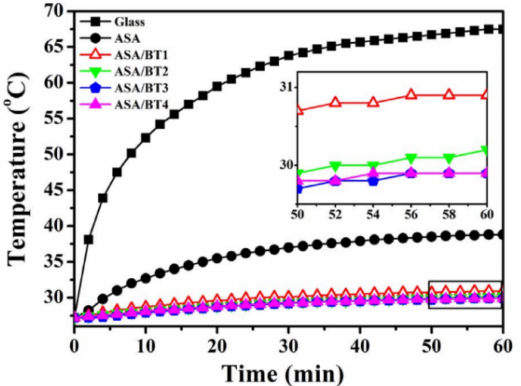
Figure 3. Inner temperature difference with respect to time [7] Copyright 2018 with permission from